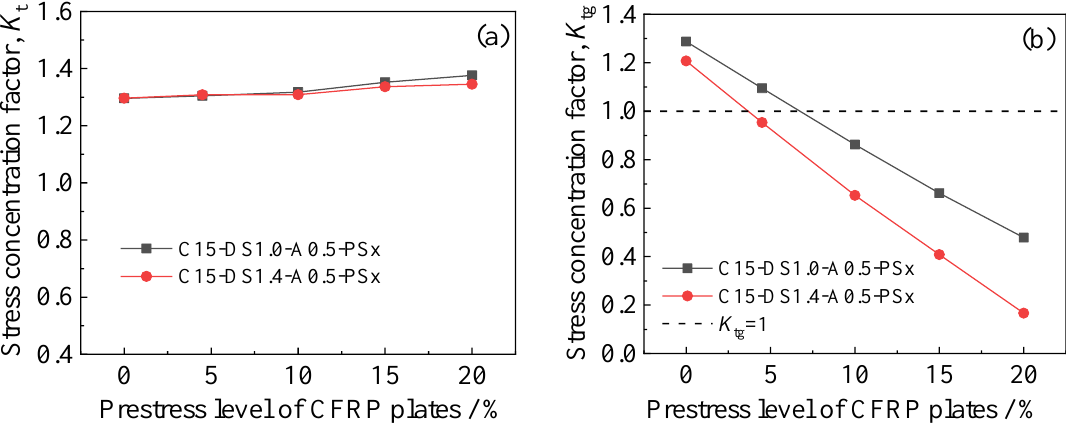
Figure 20. Effect of the prestress level of CFRP plates on the stress concentration factors ( a ) K t and ( b ) K tg of the corroded steel plates strengthened with CFRP plates.